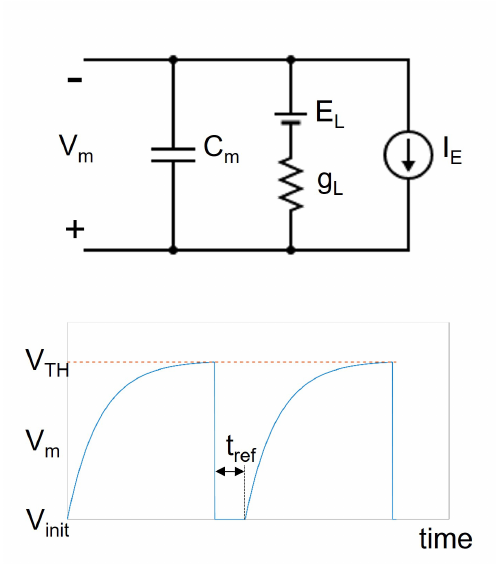
Figure 2. The upper part of the figure shows the circuital model. The lower part represents the voltage of the capacitor C m (blue line) in response to a constant current I E . It also shows the voltage reset mechanism: when the V m reaches the threshold V TH (red dashed line), its value is instantly changed to the initial one ( V init ) and it is maintained for a time equal to t ref